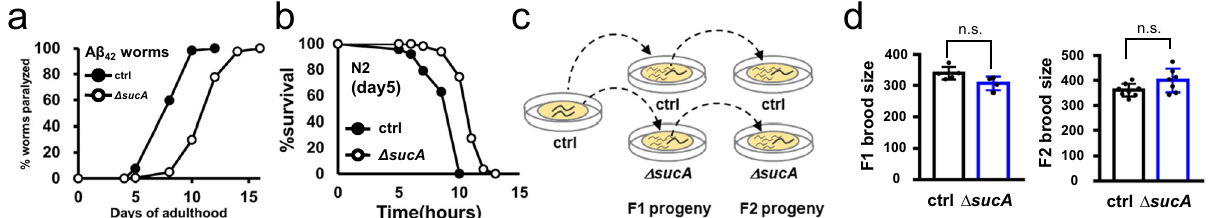
Fig. 3 | GR delays Age-associated pathologies with no germline trade-off. a Paralysis assay showing that GR diets delayed age-associated paralysis in A β 42 animals ( P <1.0×10 − 10 , P value determined by two-tailed Student ’ s t test). Results from one of three independent experiments are shown. b Survival assay showing that GR diets enhance heat stress resistance of worms at day 5 ( P <1.0×10 − 10 , P value determined by two-tailed Student ’ s t test). Results from representative experiments are shown with additional repeats. c , d Brood size analysis during